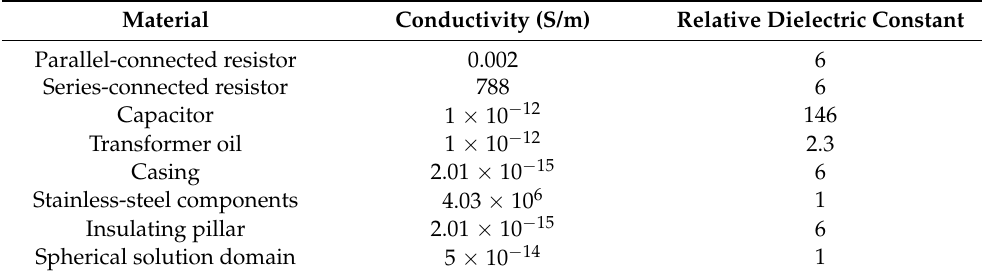
Table 1. Electrical property parameters of materials.